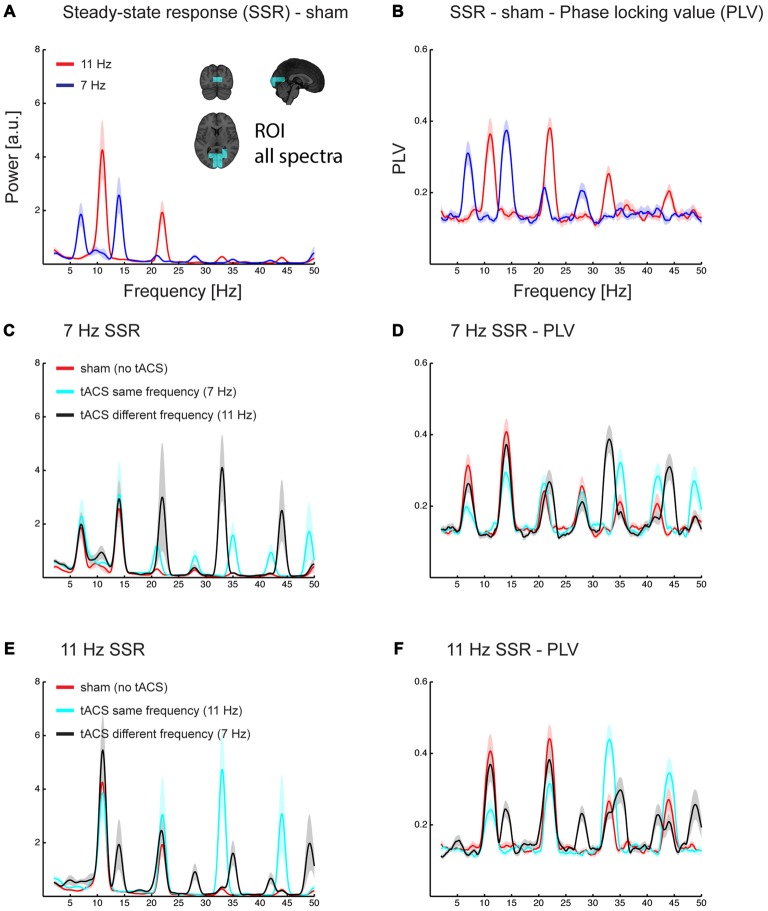
Grand average spectra of evoked power (A,C,E) and phase locking value (PLV) across trials (B,D,F). All spectra are the average of estimates in a region of interest covering early sensory visual cortex areas along the Calcarine fissure (see inlet in A). Power and PLV are shown for 7/11 Hz SSR without applying tACS (A,B) and for all three tACS conditions (no-tACS, same-frequency tACS, and different-frequency tACS) for 7 Hz (C,D) and 11 Hz SSR (E,F). Note that tACS seems to differently affect the magnitude for the fundamental and harmonics frequencies. Shaded areas represent standard error of the mean.